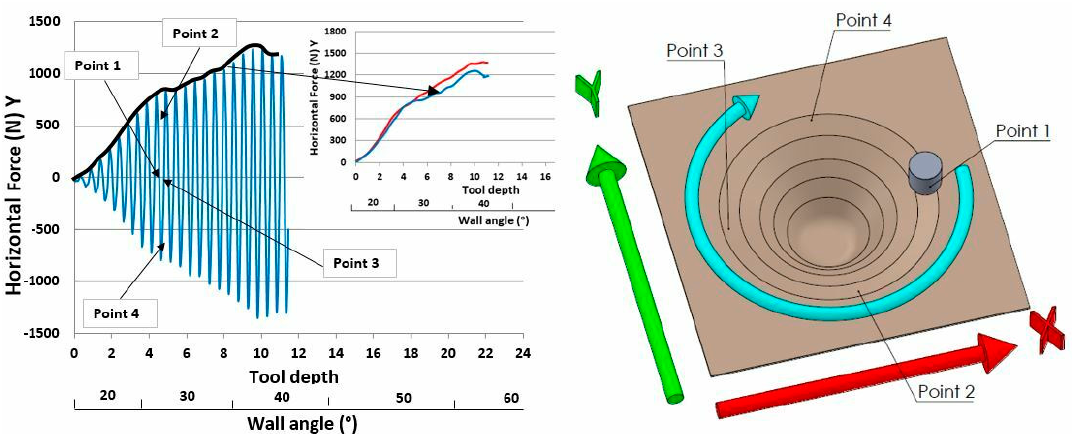
Figure 3. Representation of horizontal (radial) forces recorded during the assays.